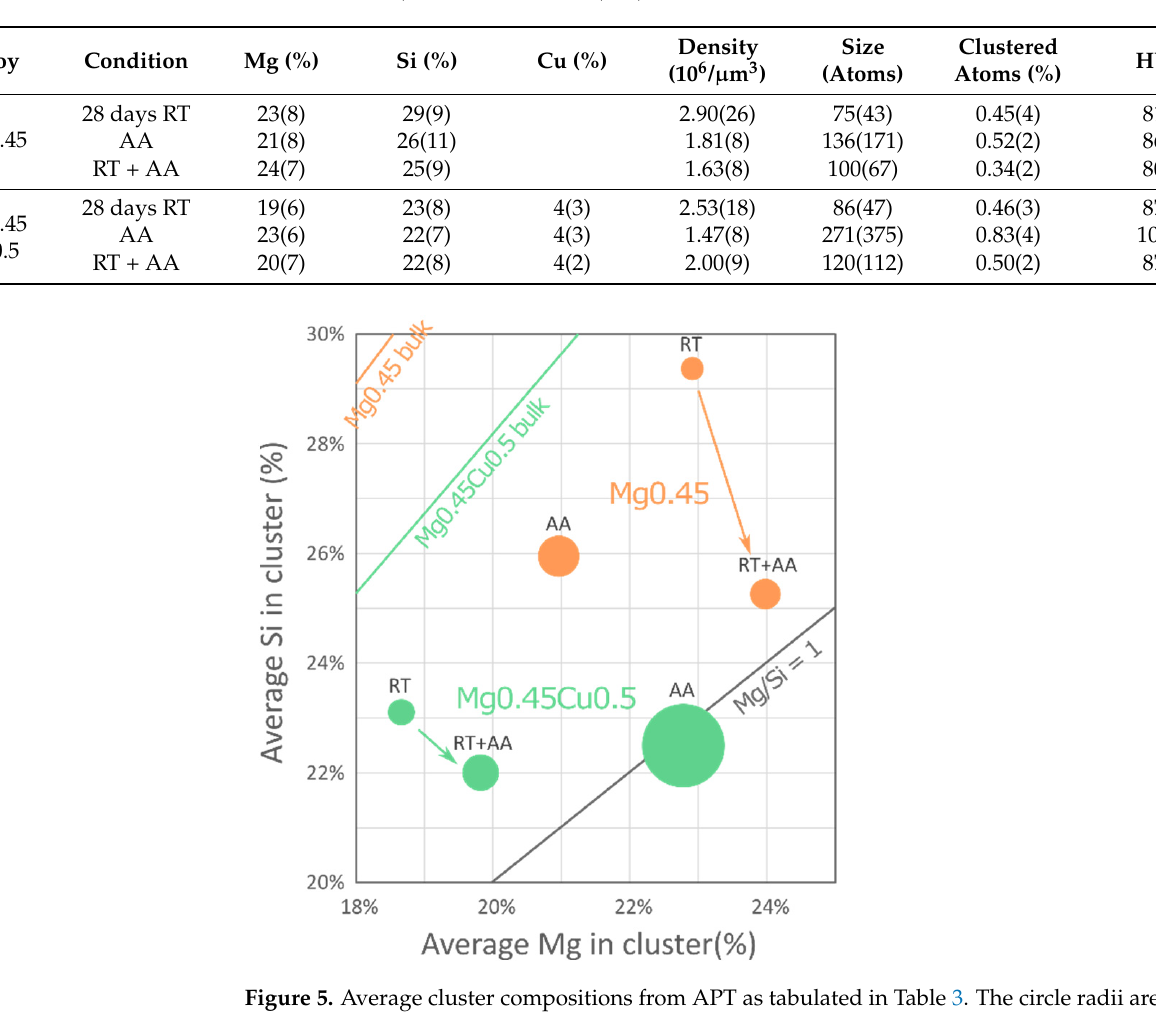
Table 3. Cluster parameters measured with APT. Average values, with standard deviations in pa- rentheses. Percentages are atomic fractions (Al is in balance). The cluster size is given in number of atoms to avoid making assumptions about cluster shape. The clustered atoms value is the ratio of atoms (Al, Mg, Si, Cu) in clusters to total atoms in the volume (approximately equal to the cluster volume fraction). Vickers hardness (HV) is included for reference. Alloy